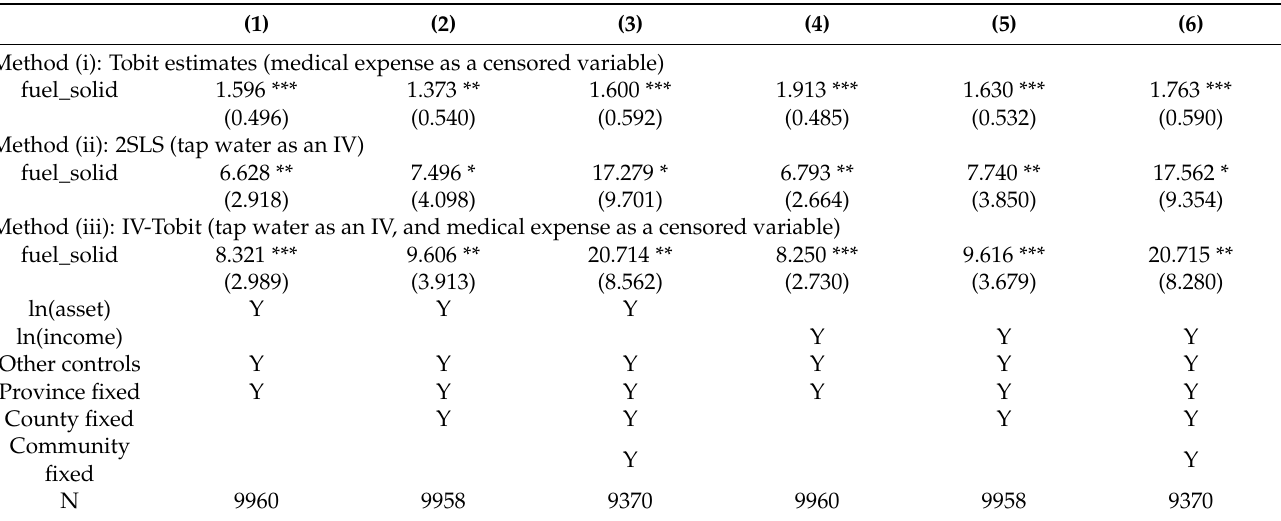
Table 4. Results of Tobit and 2SLS